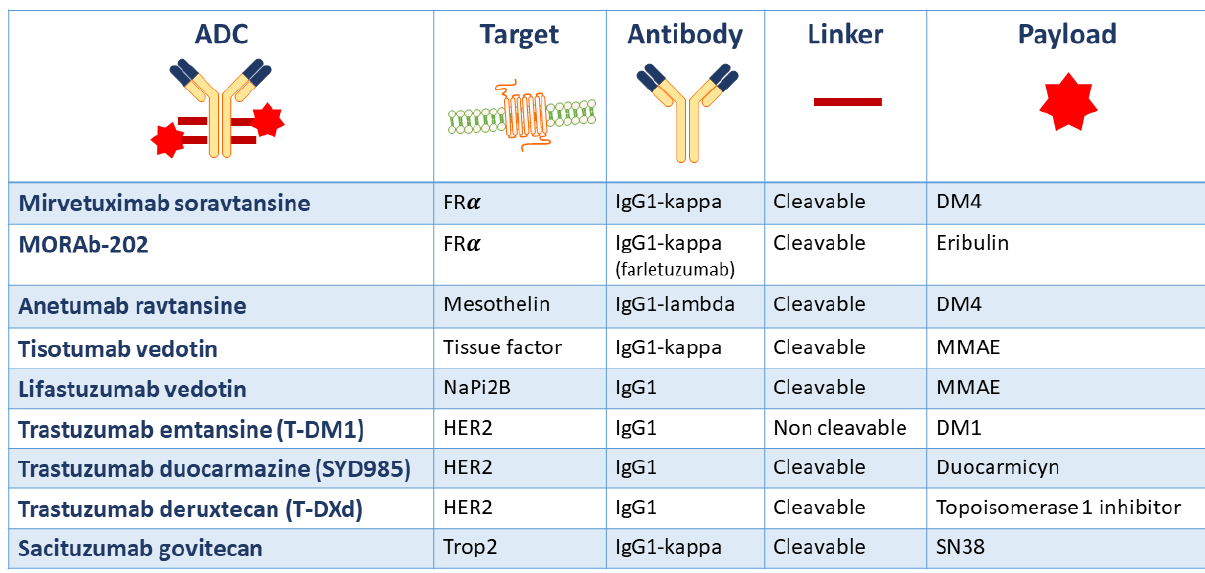
Figure 2. Main ADCs under development in gynecological cancers and their structural composition. FRα: folate receptor alfa; NaPi2b: anti-sodium-dependent phosphate transport protein 2b; Trop2: human trophoblast cell-surface marker